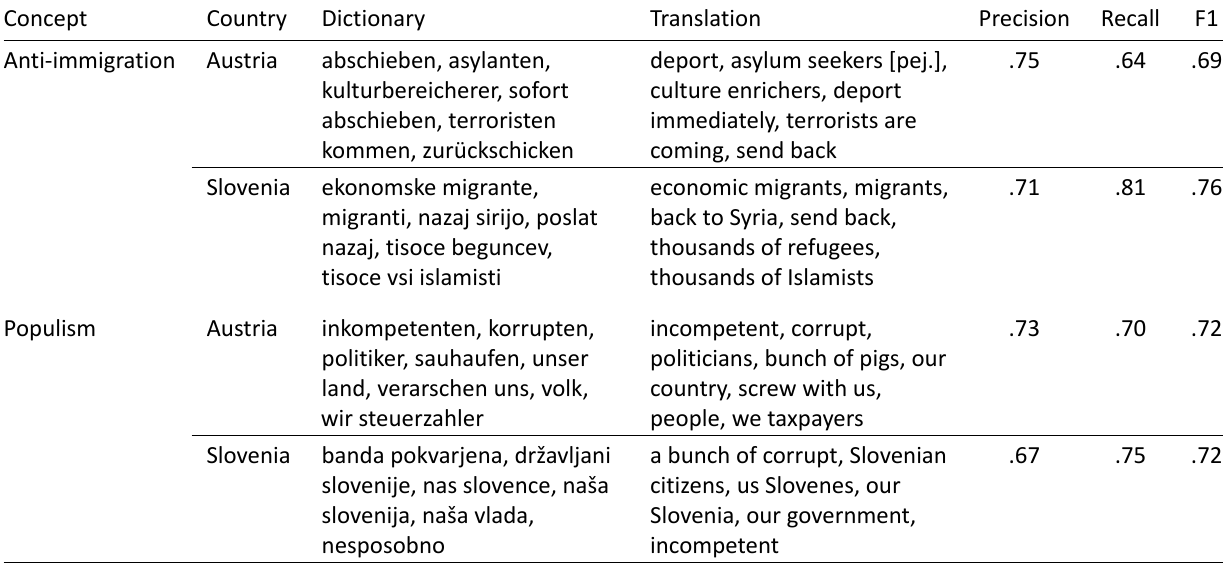
Table 1. Short dictionaries and performance of DDR measures.